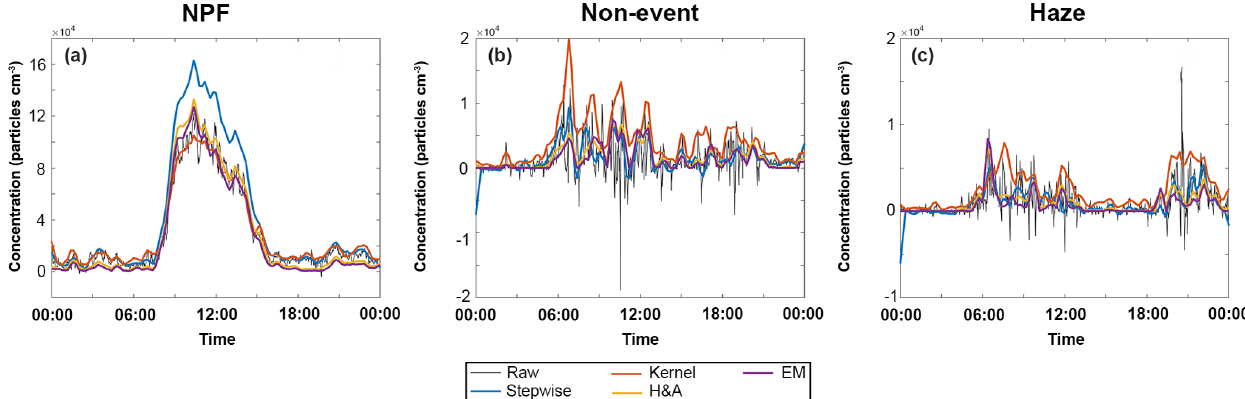
Figure 2. Comparison between inverted and raw data (i.e. R 1 . 2 − 2 . 8 ; calculated as the difference between the saturator flow rate at 1.3 and 0.1Lmin − 1 ). The event types shown are (a) a NPF event on 30 January 2018, (b) a non-event on 6 March 2018 and (c) a haze event on 9 March 2018.